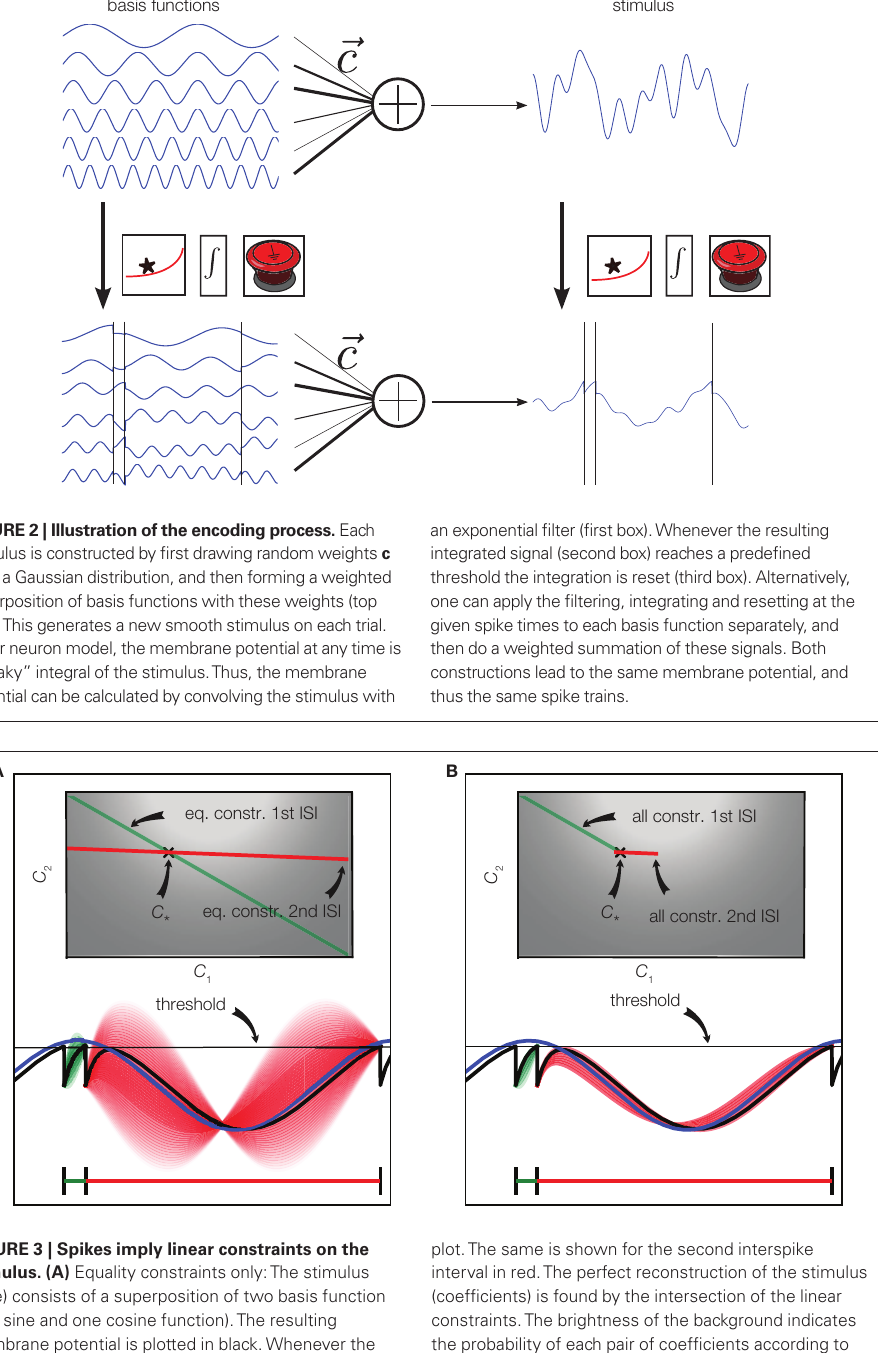
they only define an inequality constraint.